Question: Give a one-sentence summary of this figure.
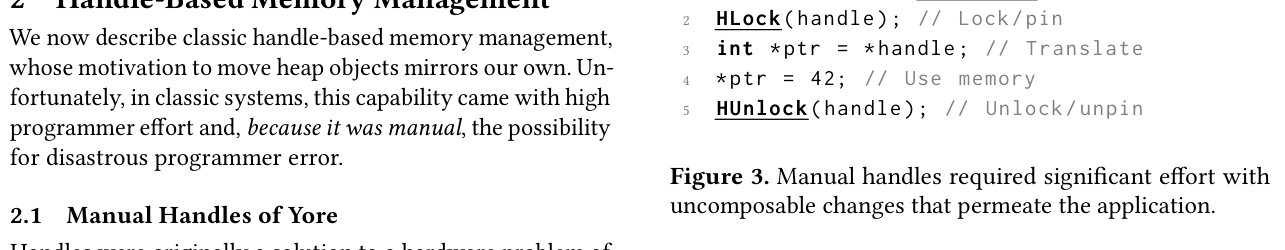
Answer: shows an example use of MacOS handles (trans- lated from the original Pascal to C). Manually adding handles to a program required significant effort—the majority of the lines shown are concerned with their management. Han- dles are allocated with the NewHandle function. In order to safely access the data behind the handle the user must first call HLock, setting a bit in the handle to indicate it has been locked/pinned. This allows the programmer to safely access the backing memory of the handle without concern for object movement. When done accessing the object, programmers must call HUnlock. With manual handles, programmers were required to con- sider an additional lifetime—that of their pins—which came with tradeoffs. Being overly cautious with pins (i.e., surround- ing individual memory accesses with pin/unpin) is easier to understand, but produces terrible performance from the additional memory updates needed to pin, unpin and trans- late handles. Conversely, pinning acros